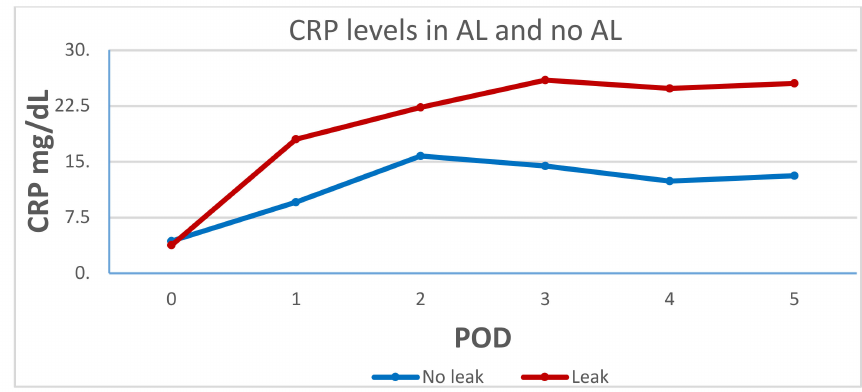
Figure 1. C-reactive protein (CRP) levels in the anastomotic leak (AL) and the no-AL groups. ROC curves were produced for POD 3–5 and analyzed to calculate the area under the curve and optimum CRP threshold (see Figure 2). ROC curve analysis revealed POD 3 to be the most predictive of AL, with an AUC of 0.863 for a CRP threshold value of 19.56 mg/dL (sensitivity 88%, specificity 73%). On POD 4, the AUC was 0.805 for a CRP threshold value of 20 mg/dL (sensitivity 66%, specificity 90%).